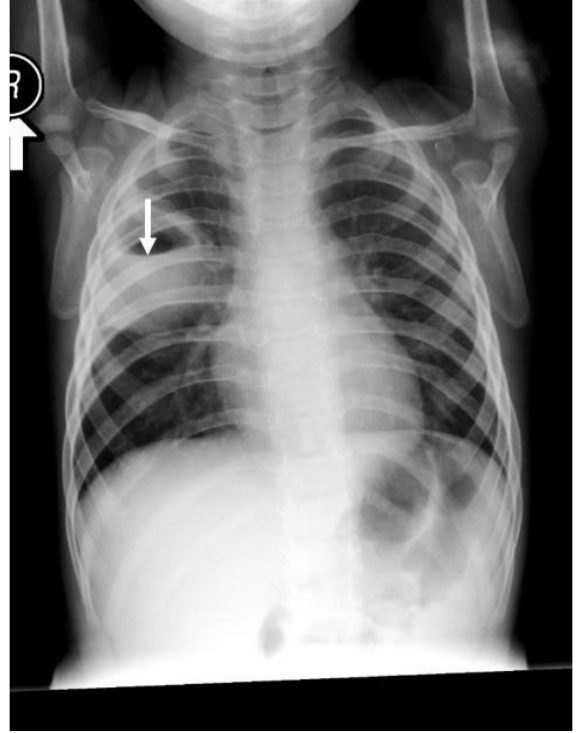
Figure 6. Large, homogenous, rounded, density of 3 × 3 cm in the right upper zone with a large amount of air fluid and thick wall cavity. The white arrow shows the upper part of the fluid level.